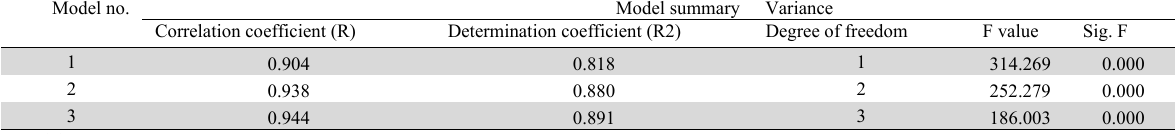
The results of the stepwise multiple regression analysis for exploring the degree to which the environmental quality is affected by each digital entrepreneurship dimension Model no.